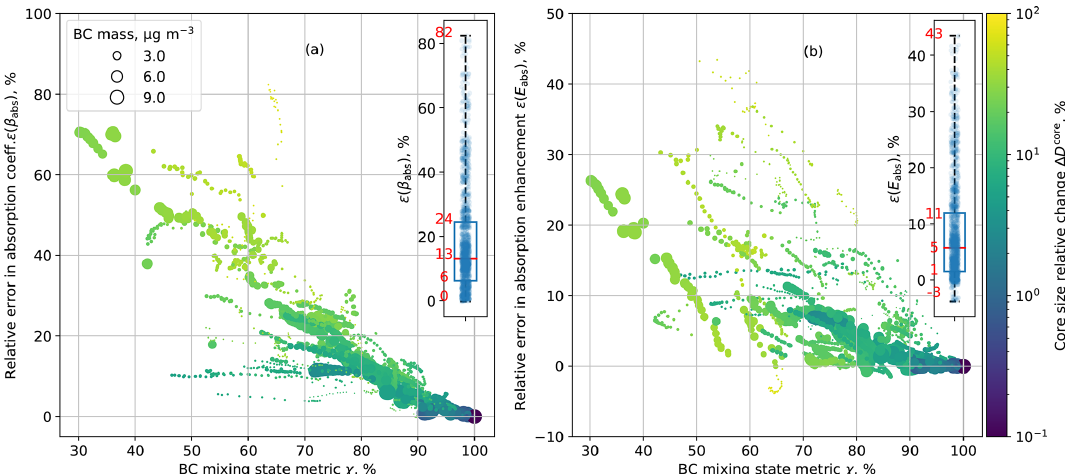
Figure 4. Relative error in absorption coefficients (a) (cid:15) ( β abs ) and (b) (cid:15) ( E abs ) after composition averaging for dry particles. Each marker represents an aerosol population. The color denotes the change of BC diameter due to composition averaging, and the marker size represents BC bulk mass in the population. The box plot inset shows the distribution of the error. The red line shows the median, and the edges of the dashed lines are the minimum and maximum values. Red numbers are for the minimum, first quartile, median, third quartile and maximum